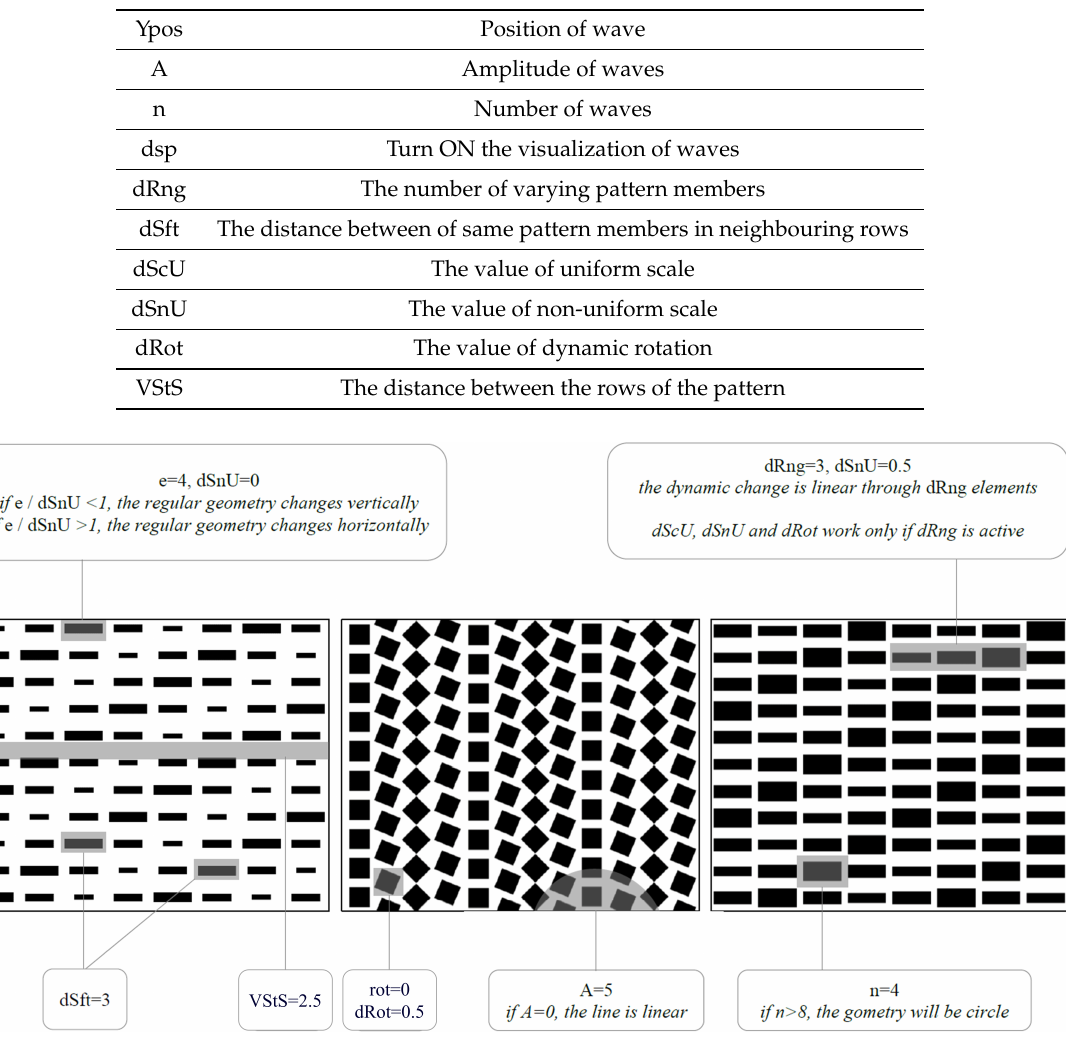
Figure 8. Basic shape and pattern space